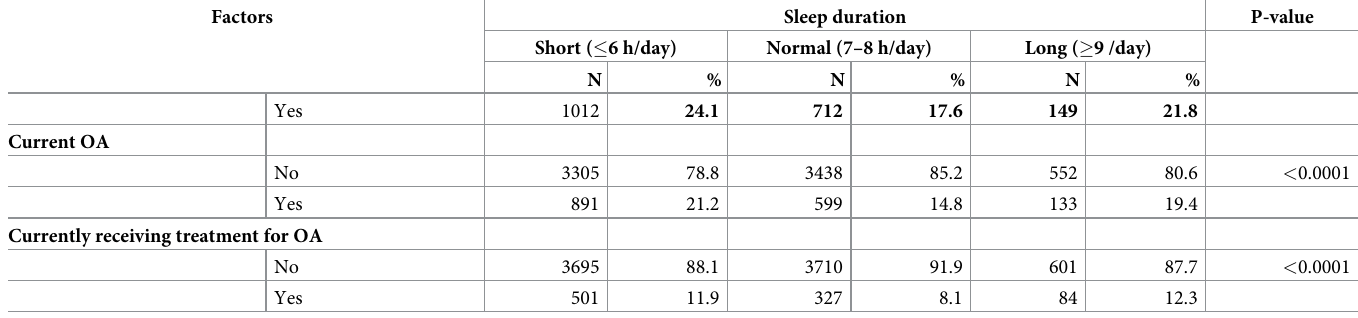
day. Table 1 shows that OA occurrence, OA diagnosis by a doctor, and current OA treatment